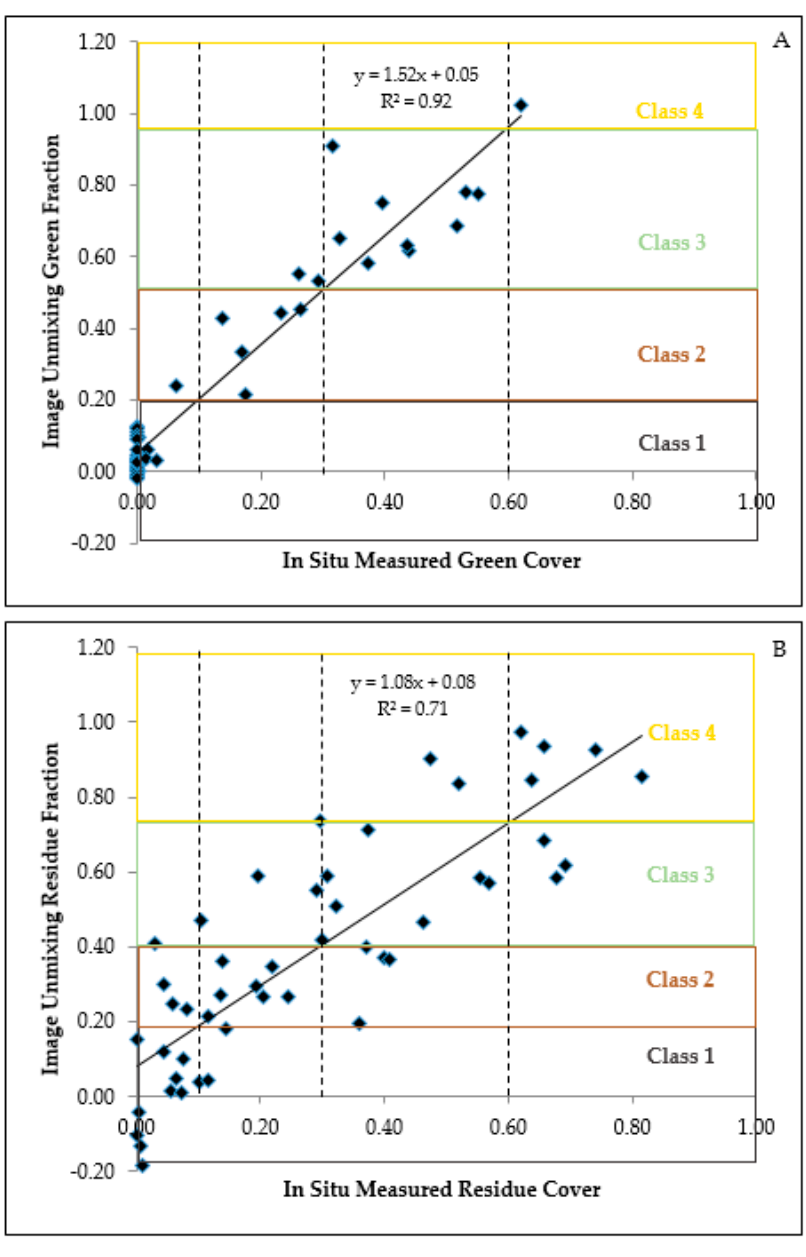
Figure 5. Illustration of breakpoints in fraction values used to define common soil cover (e.g., green cover ( A ) or residue ( B )) classes. Data from the 18/30 2016-04-18 image ( n = 49).